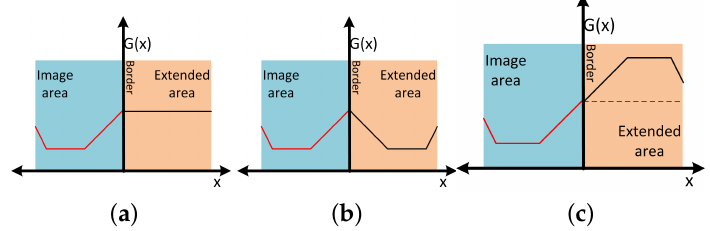
Figure 6. Examples of pixel values in the padding zone for one line of the image. ( a ) Duplicate; ( b ) mirror; ( c ) mirror-inverted.